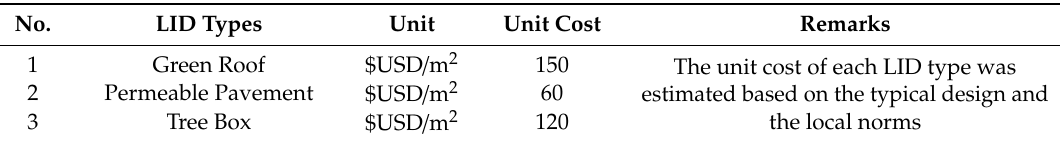
Table 3. Unit cost of LID